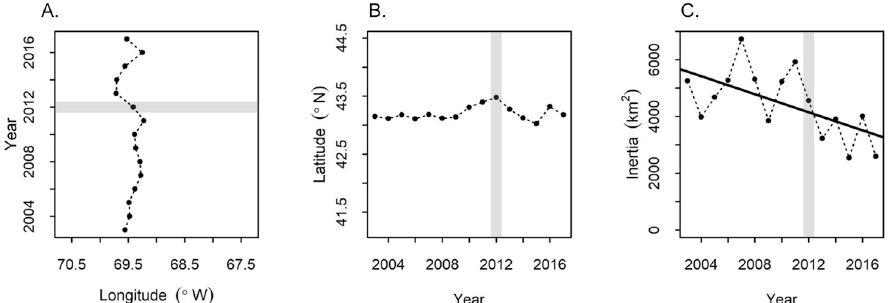
Fig 5. Results of spatial analysis showing no trend in location but significant contraction of occupied area. Changes over time in (A.) longitude (back-transformed from XCG), (B.) latitude (back-transformed from YCG) and (C.) inertia (variance of center of gravity) for northern shrimp in NEFSC fall surveys during 2003–2017. Shaded bar highlights 2012, when the shrimp decline became apparent.